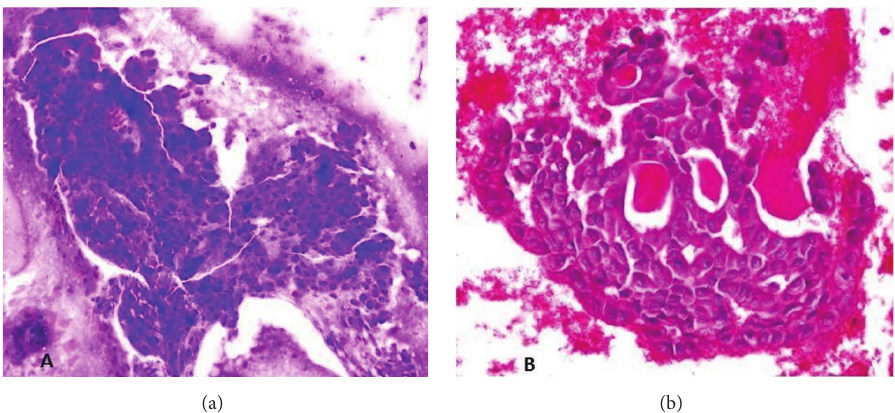
Figure 3: Cytology smears of FNAC ((a) Diff-Quick and (b) H&E stain) show a low grade epithelial tumor with round to oval nuclei. Eosinophilic secretions are seen in H&E image